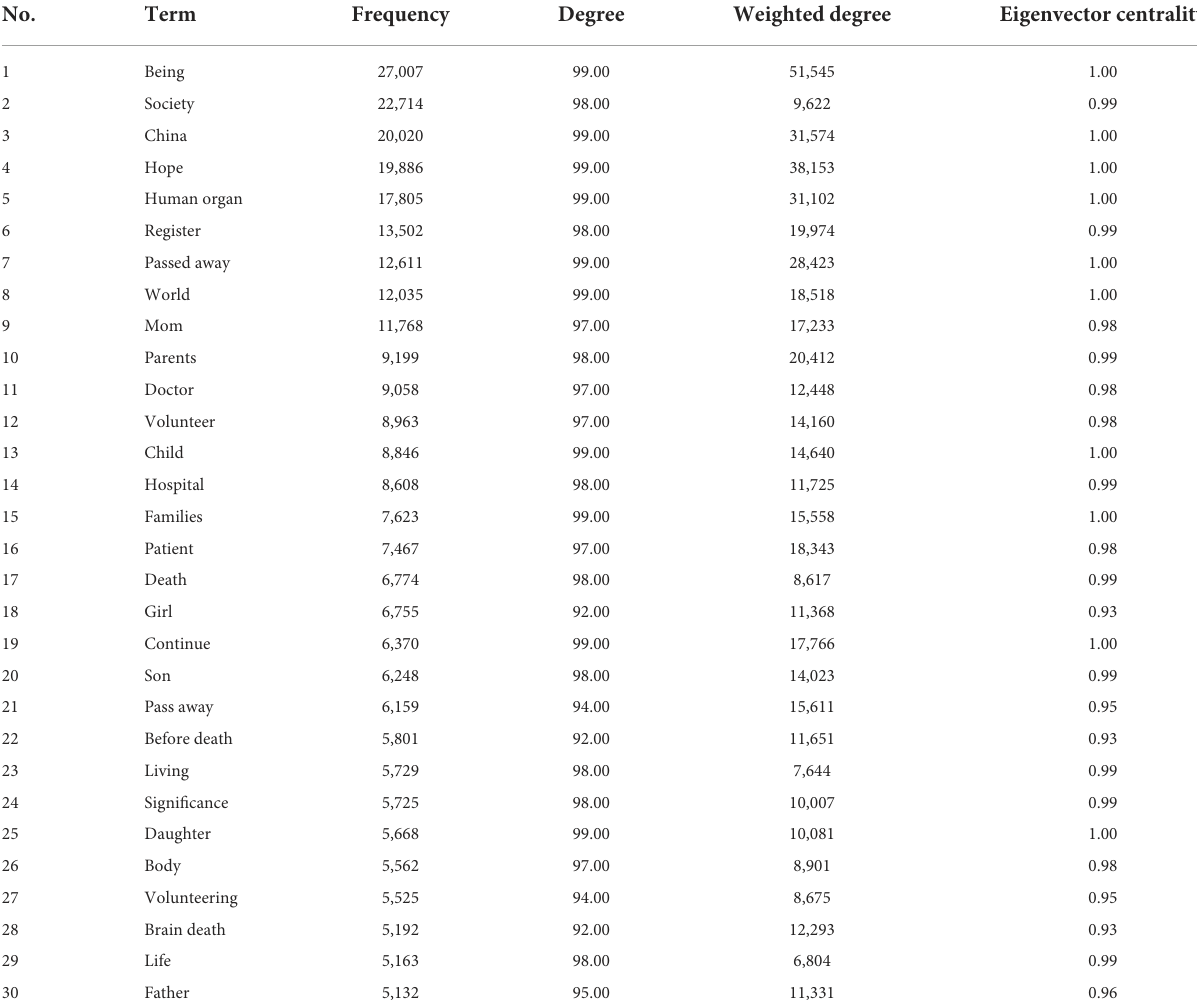
TABLE 1 Summary output of the top 30 central terms in the semantic network. No.